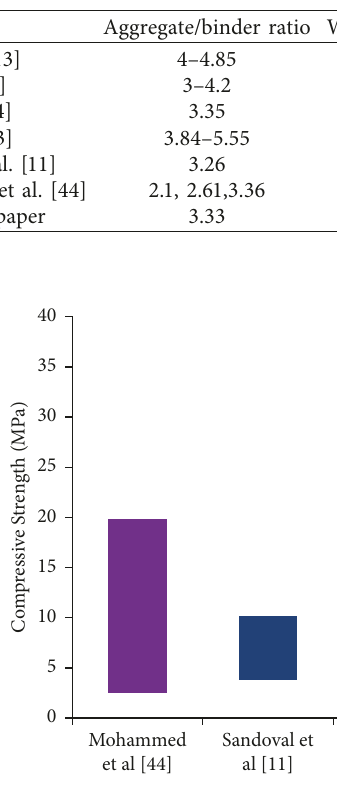
Table 5: Latest reference of mix proportion and properties of pervious concrete.